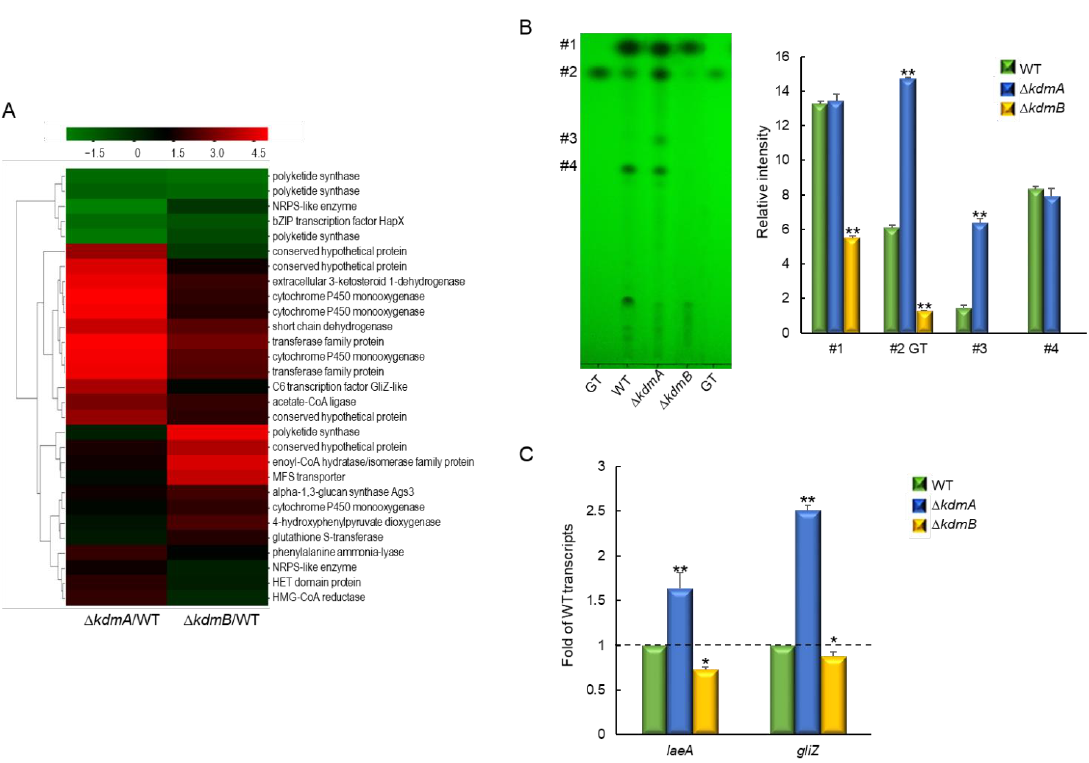
Figure 5. Roles of KdmA and KdmB in the production of gliotoxin (GT) and other putative secondary metabolites. ( A ) Heatmap of altered expression levels of genes encoding secondary metabolite biosynthesis in mutant strains. ( B ) Determination of GT production and several secondary metabolites in the WT and mutant strains. Standard GT concentration was 10 µ g (left side) and 5 µ g (right side). Left: a representative thin-layer chromatogram of the culture supernatant of each strain extracted with chloroform. Right: a graph of relative intensities of individual chromatogram bands in culture supernatants from different strains. ( C ) RT-qPCR analysis of changes the laeA and gliZ gene expression levels in mutant strains compared to that in the WT strain. Dot line indicates the level of WT transcript. Statistical significance of differences between WT and mutant strains was assessed by Student’s t -test: * p < 0.05, ** p <